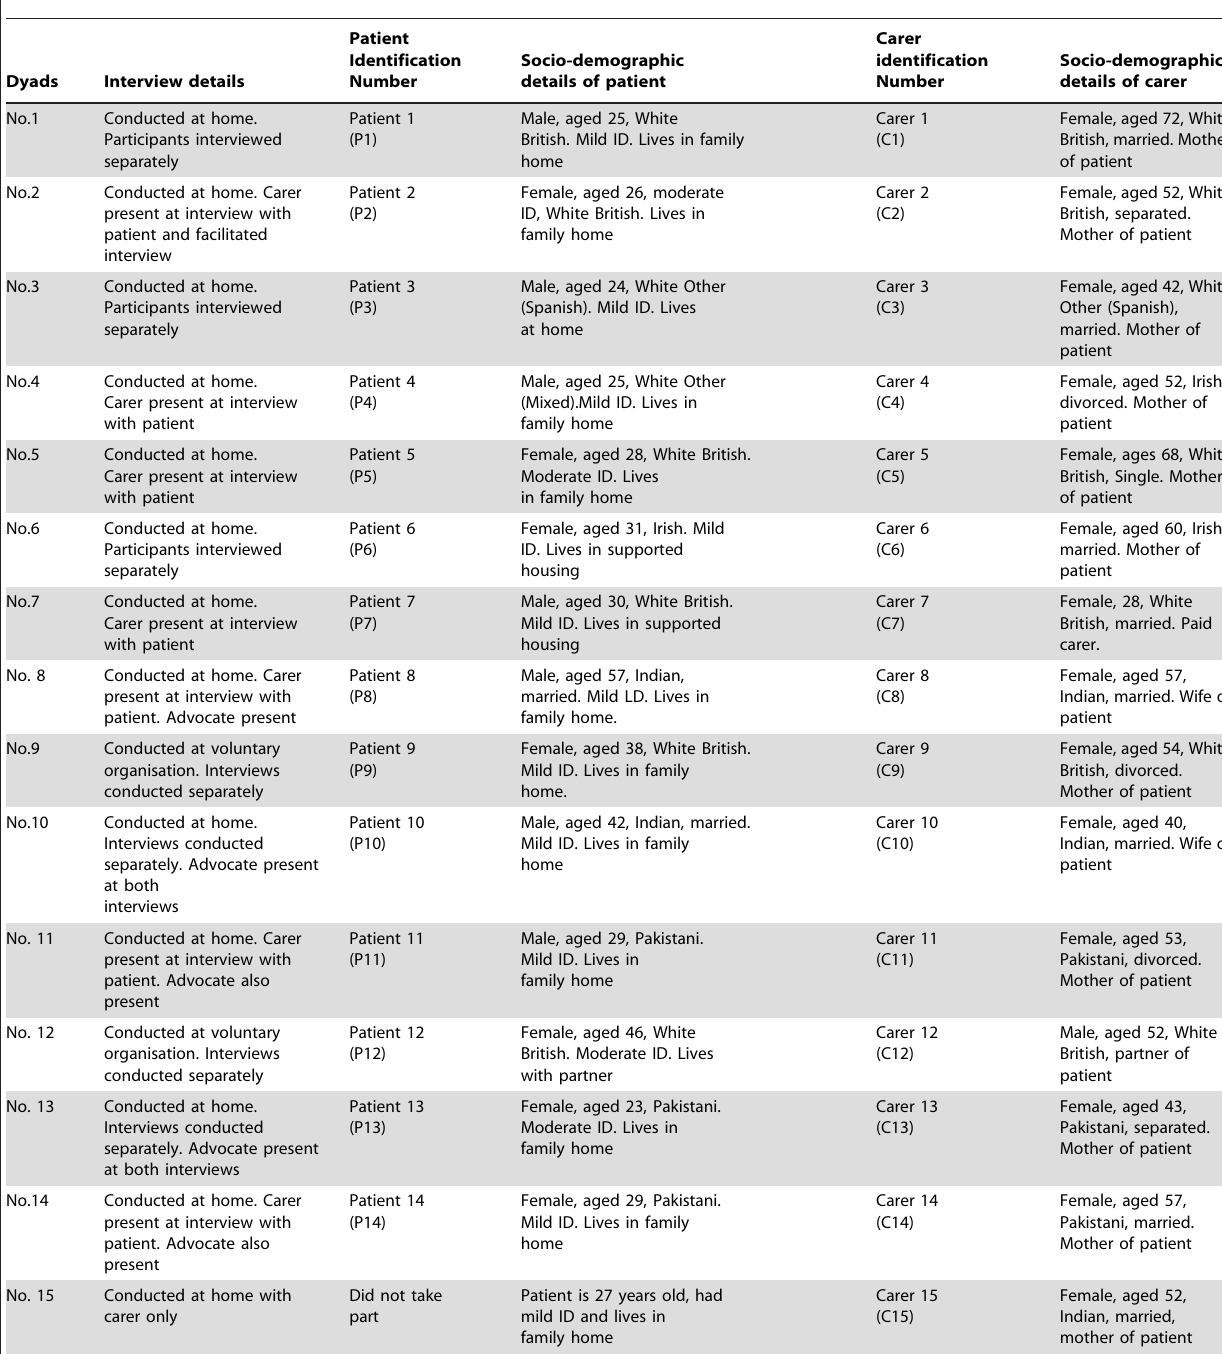
from health services; and good practice (Table 2). These themes are discussed in detail and illustrated with interview extracts below. The notation used in the brackets refers to the participant identification numbers shown in Table 3 (C denotes carers and P denotes patients).